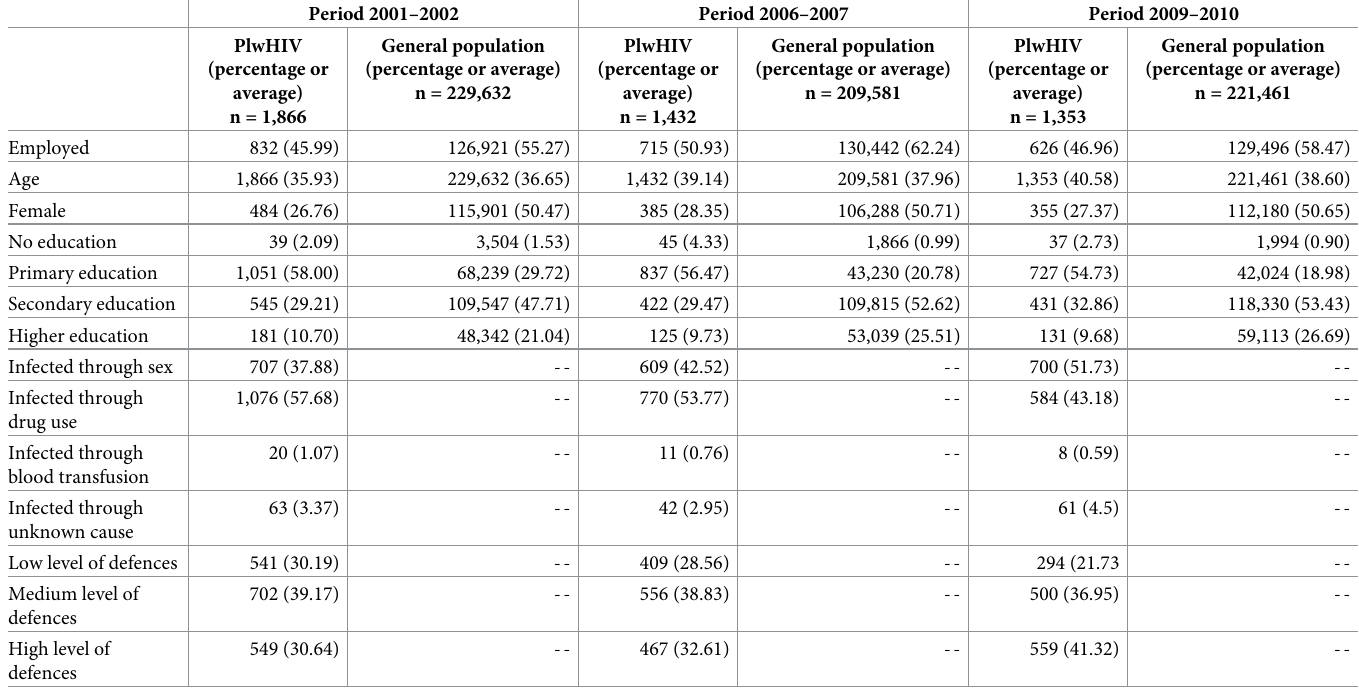
Table 1. Sample characteristics for PlwHIV and the general